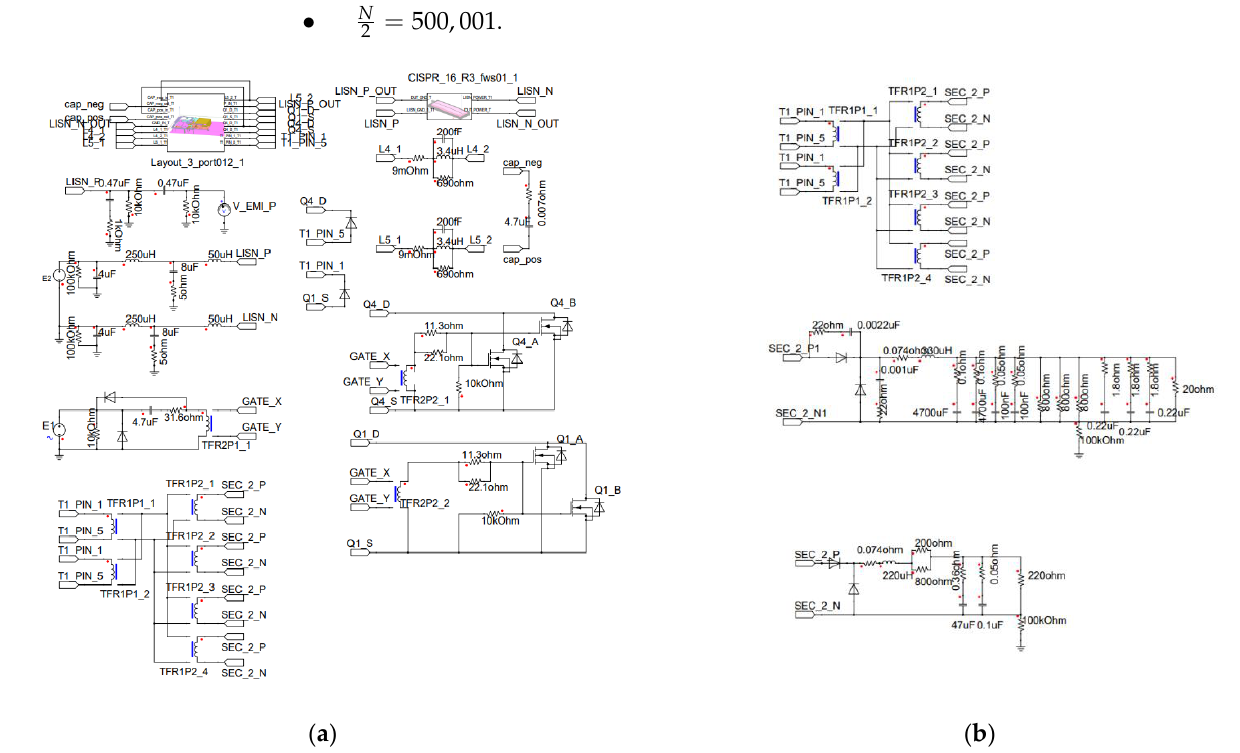
Figure 18. Electrical schematic for transient simulation — HFSS approach: ( a ) LISN and primary side; ( b ) secondary side.